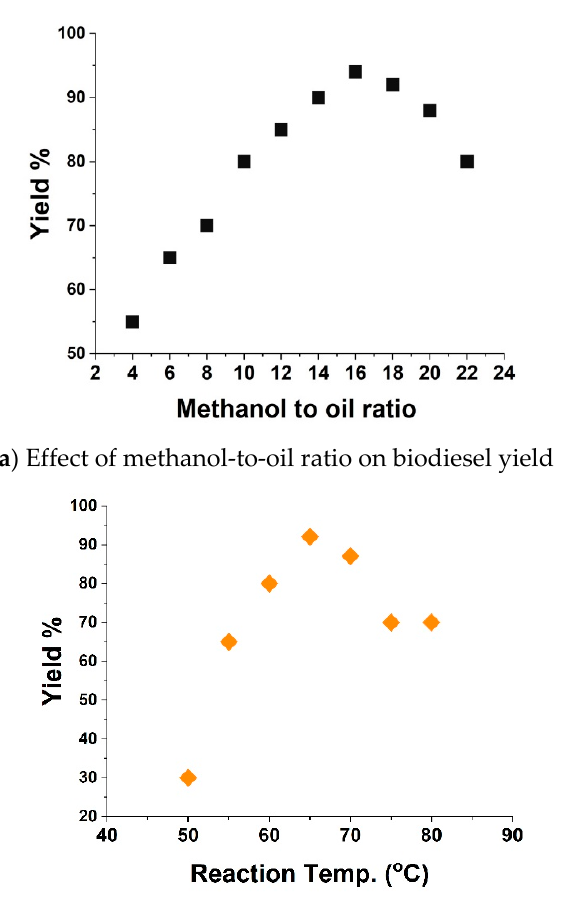
Figure 7. FTIR spectrum [CaCu(OCH 3 ) 2 ] catalyst.